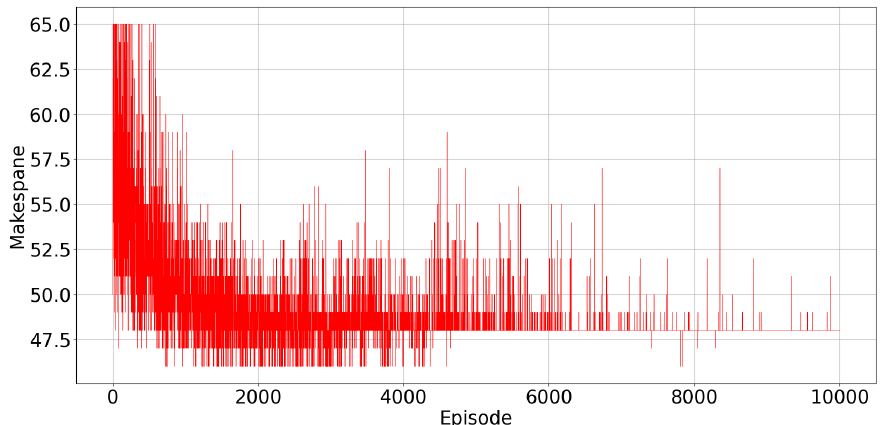
Figure 5. Scenario 1: Observed make-span at each training